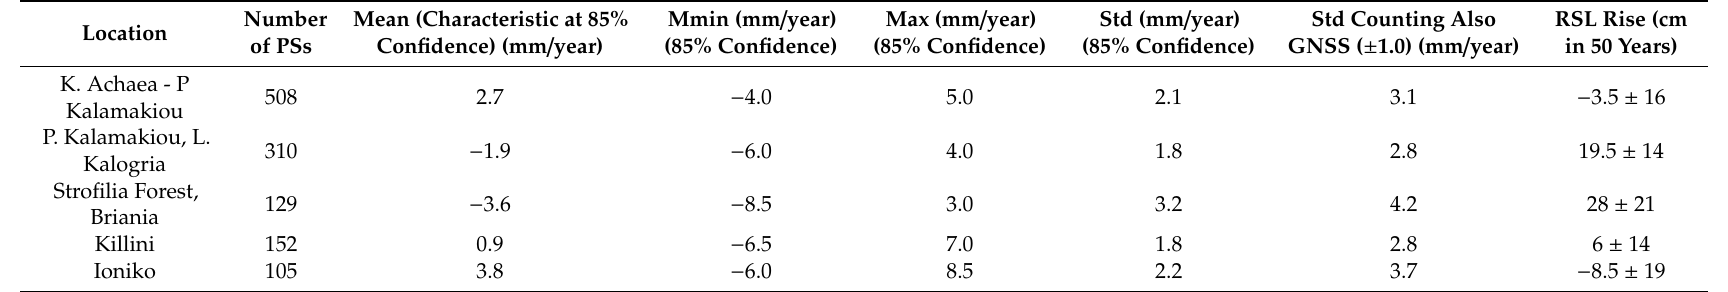
Table 5. Statistics of the sub-areas of the Killini, Araxos. Amongst others the characteristic (mean) values of vertical deformation rate, the relative sea level rise and the uncertainty are shown. PS stands for permanent scatterers; GNSS for Global Navigation Satellite System; RSL for relative sea